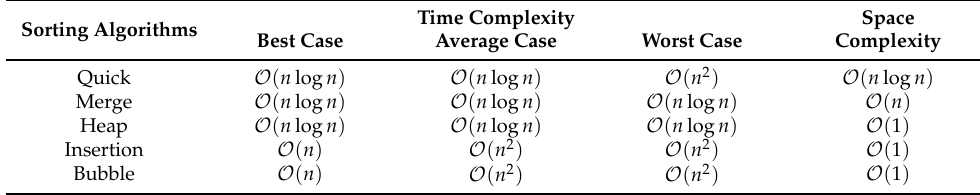
Table 4. Computational complexities of commonly used sorting algorithms.